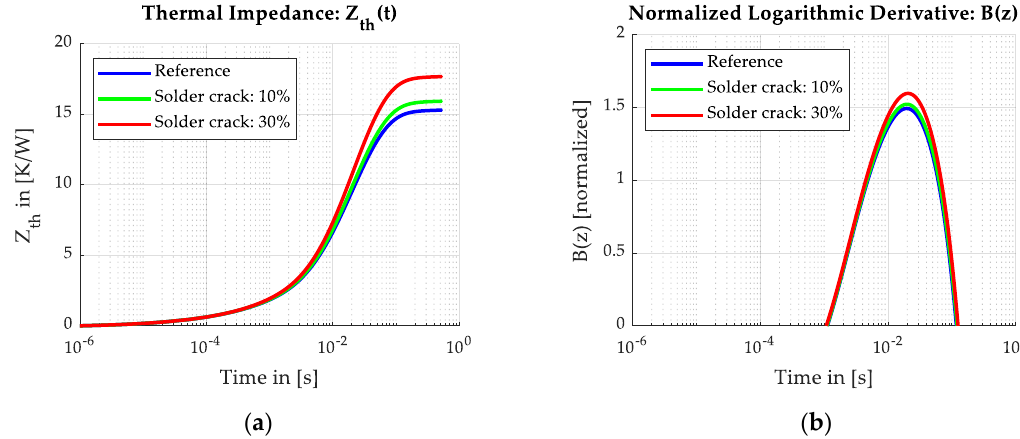
Figure 4. Evaluation methods in TTA: ( a ) Z th evaluation and ( b ) normalized logarithmic derivative. Data are generated by an optimized FEM model in a transient thermal simulation with a crack growth of 10% or 30% in the solder joint compared to its area described in [44]. An increase of 0.63 K / W or 2.37 K / W was observed in Z th ( t ) and 0.012 or 0.044 in peak increase for